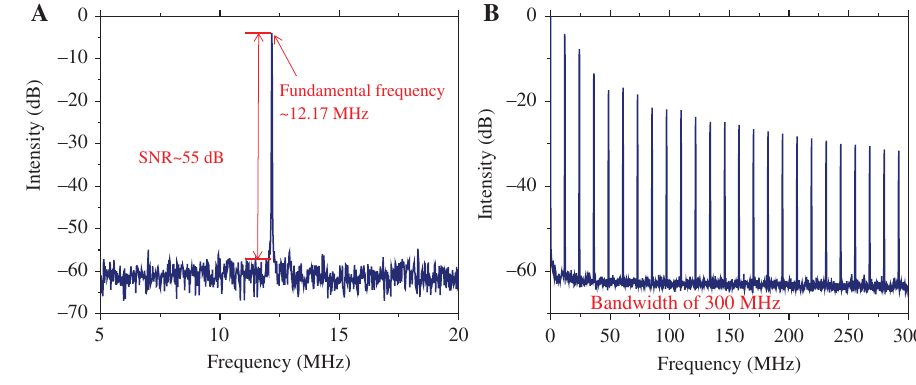
Figure 11: Stability characteristics of the NLP operation.